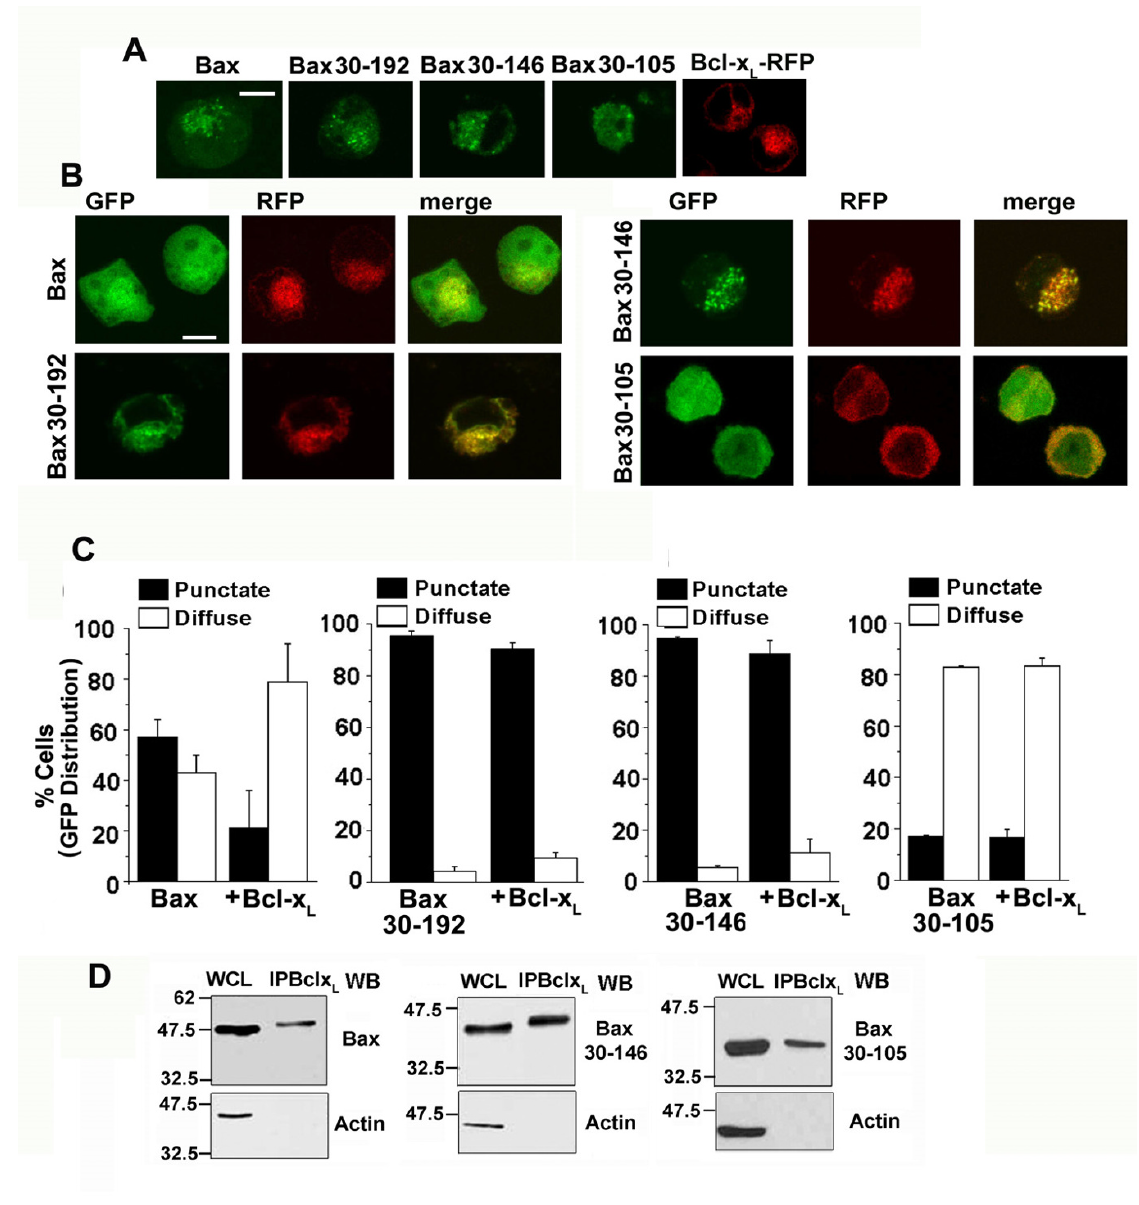
Figure 6 The Bax N-terminus or TM1 domain is not essential for association with Bcl-x . A, HEK cells transfected with Bax- L cal microscopy. Representative images (processed as described in methods) are shown. Scale bar: 10 microns B, HEK cells transfected with each of the constructs in A and RFP-Bcl-x were harvested 15 hours post-transfection. Confocal images for L distribution of Bax constructs (green) and RFP-Bcl-xL (red) were assessed for co-localization (Merge, right panel). Scale Bar: 10 microns. Representative images (each corresponding to a single image field) are shown. C, From the experiment in B, cells pos- itive for GFP and RFP were scored for punctate or diffuse patterns of GFP by microscopy. The data are representative of two independent analyses. D, HEK cells transfected with Bax-GFP + Bcl-x (left panel) or Bax 30–146-GFP + Bcl-x (middle panel) L L or Bax 30–105-GFP + Bcl-x (right panel) were harvested after 15 hours of culture. Bcl-x was immunoprecipitated from cell L L lysates and the immunoprecipitates assessed by western blot analysis for Bax or the mutant constructs using an antibody to GFP and for the presence of actin. WCL represents the CHAPS buffer solubilized whole cell lysate, which was used for immu-